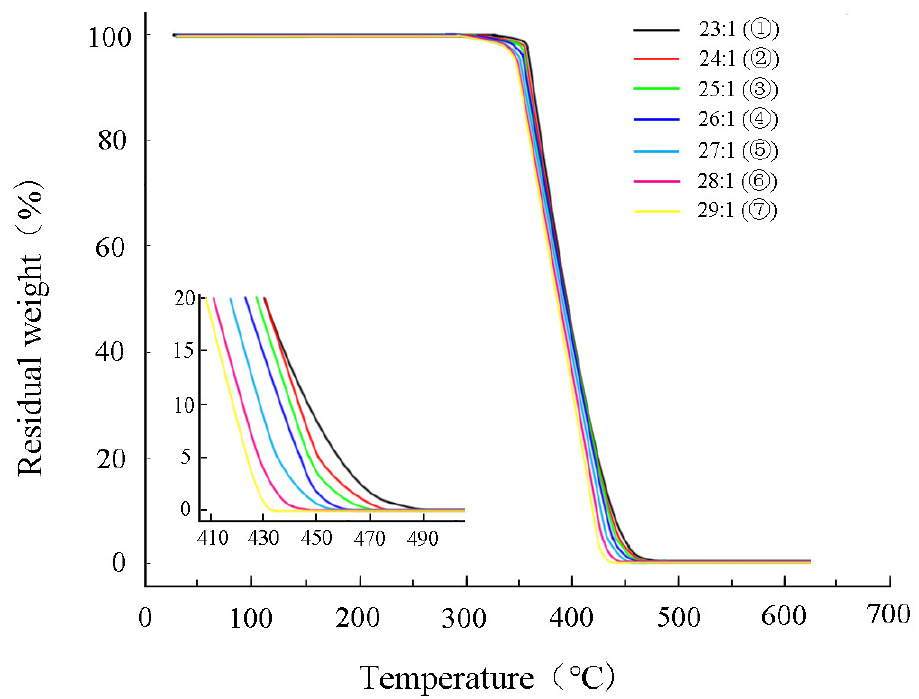
Figure 4. Thermogravimetric curves of prepolymers prepared with different amounts of fluorine monomers (Samples with different molar ratios of epoxy group to DFHMA).